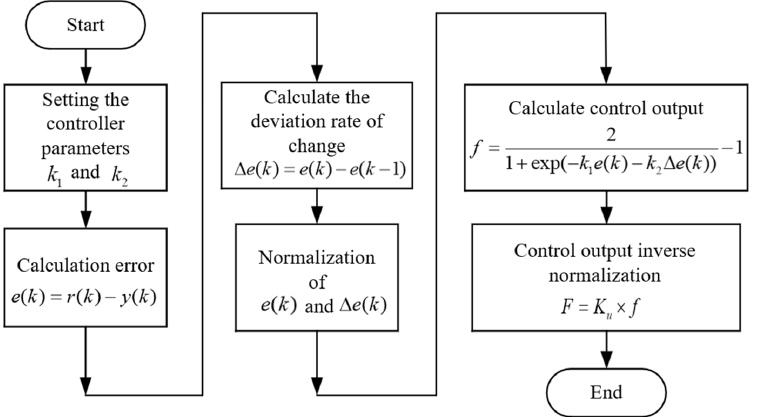
Figure 4. Flow diagram of standard S-plane control algorithm. The algorithm flow contains a total of 6 steps. 6 Table 1. Steps of the flow diagram of standard S-plane control algorithm. Steps